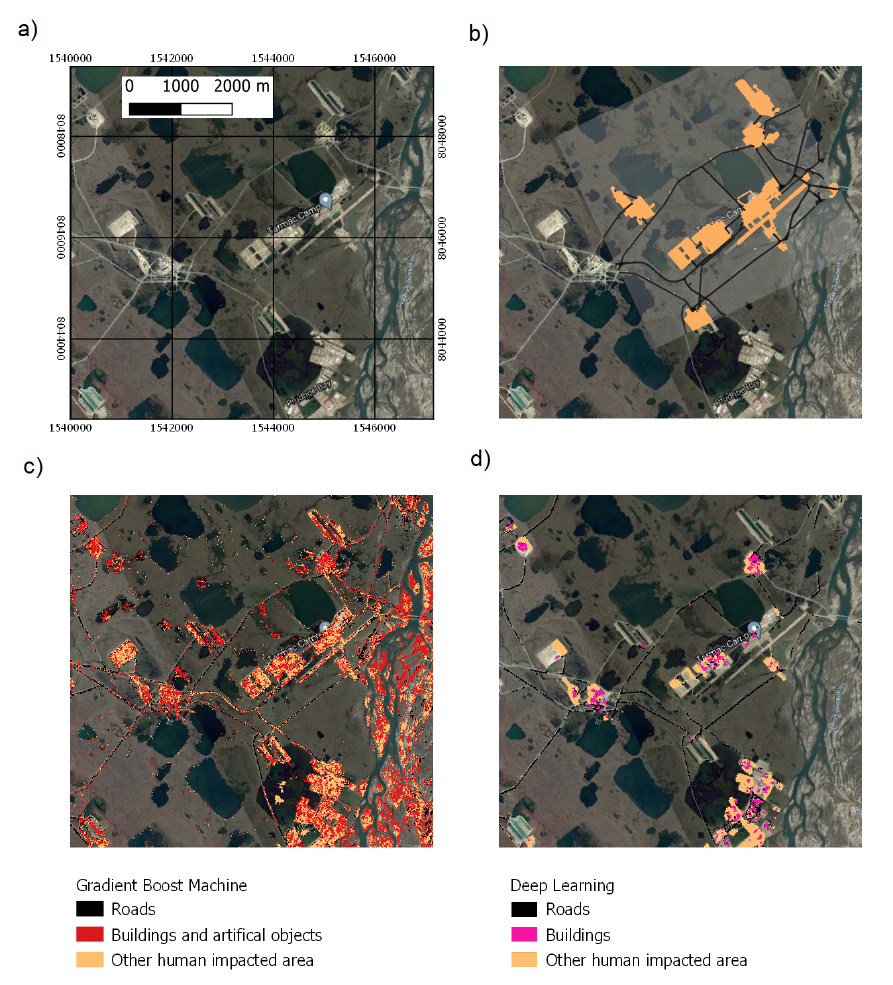
Figure 10. Validation data and results for part of the Prudhoe Bay region (WGS 84/UTM zone 5N): ( a ) Google Hybrid background map, ( b ) high-resolution validation dataset (area C of the work in [3]), ( c ) Gradient Boost Machine classification result, and ( d ) Deep Learning